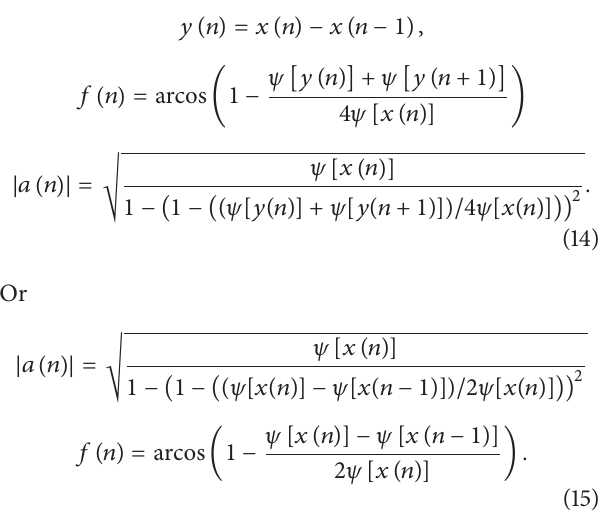
algorithm (DESA-1) for the instantaneous frequency and amplitude of an AM-FM signal as